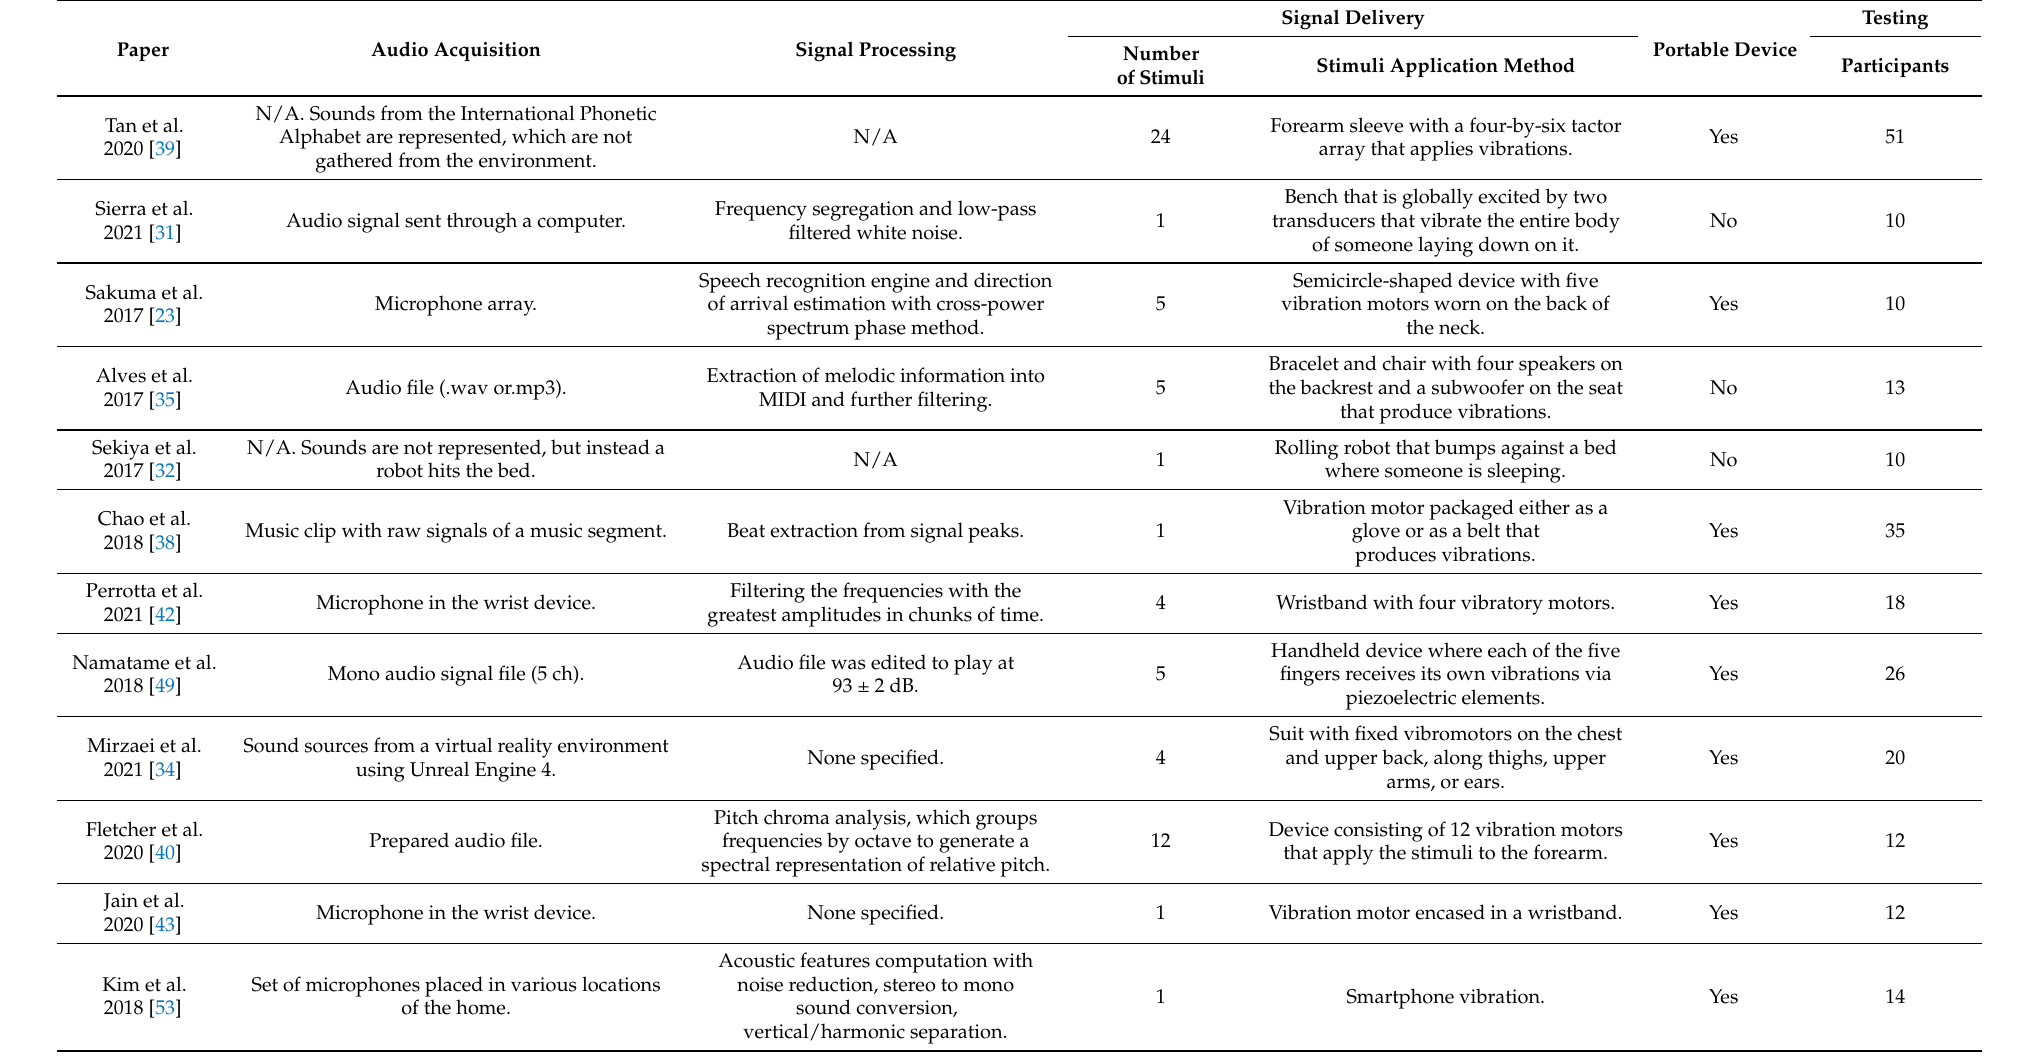
Table 8. Device specifications focusing on the input, its processing, and the output/stimuli application, as well as the number of users it was tested